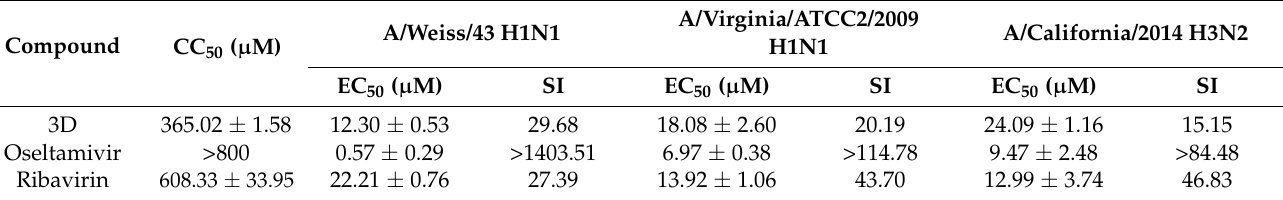
Table 2. Antiviral activities of different drugs against influenza virus (IAV) strains.